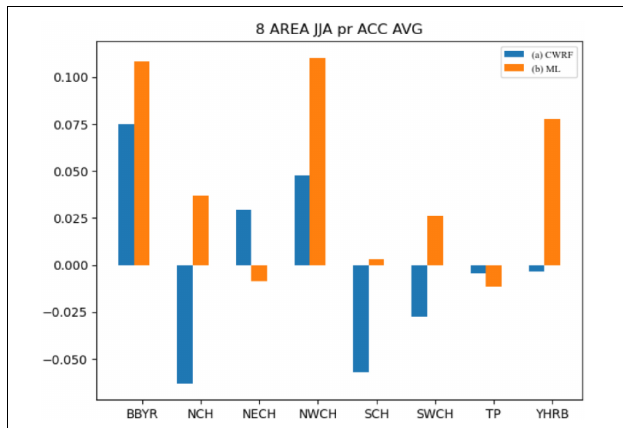
FIGURE 8 | Comparison of mean values of spatial correlation coefficients of regional precipitation (CWRF vs. ML). (a) CWRF prediction and (b) machine learning correction.